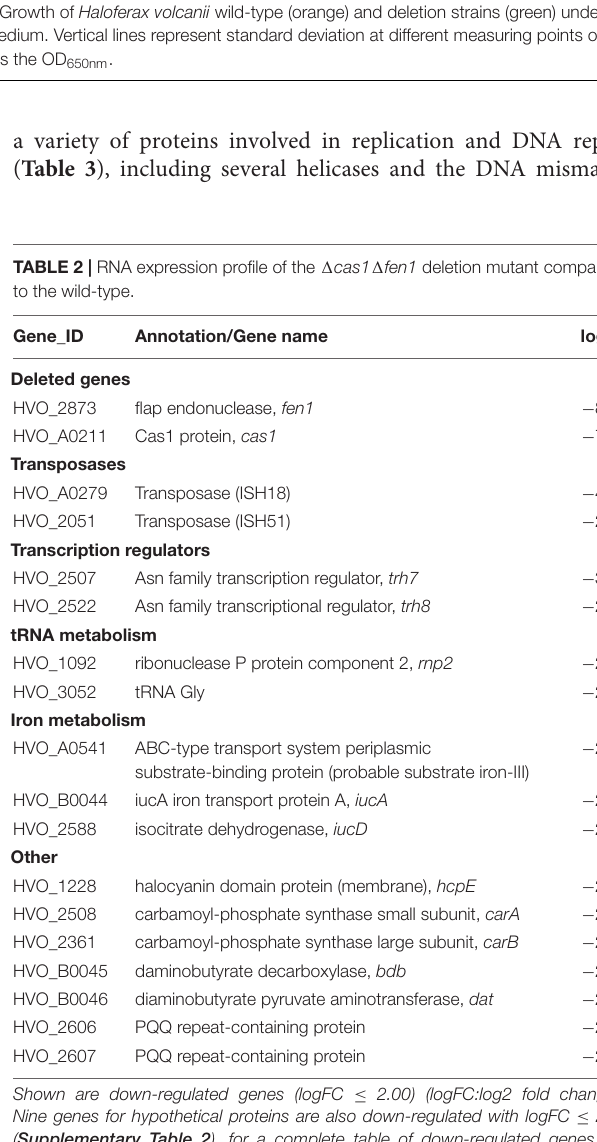
( Supplementary Table 2 ), for a complete table of down-regulated genes see Supplementary Table 2